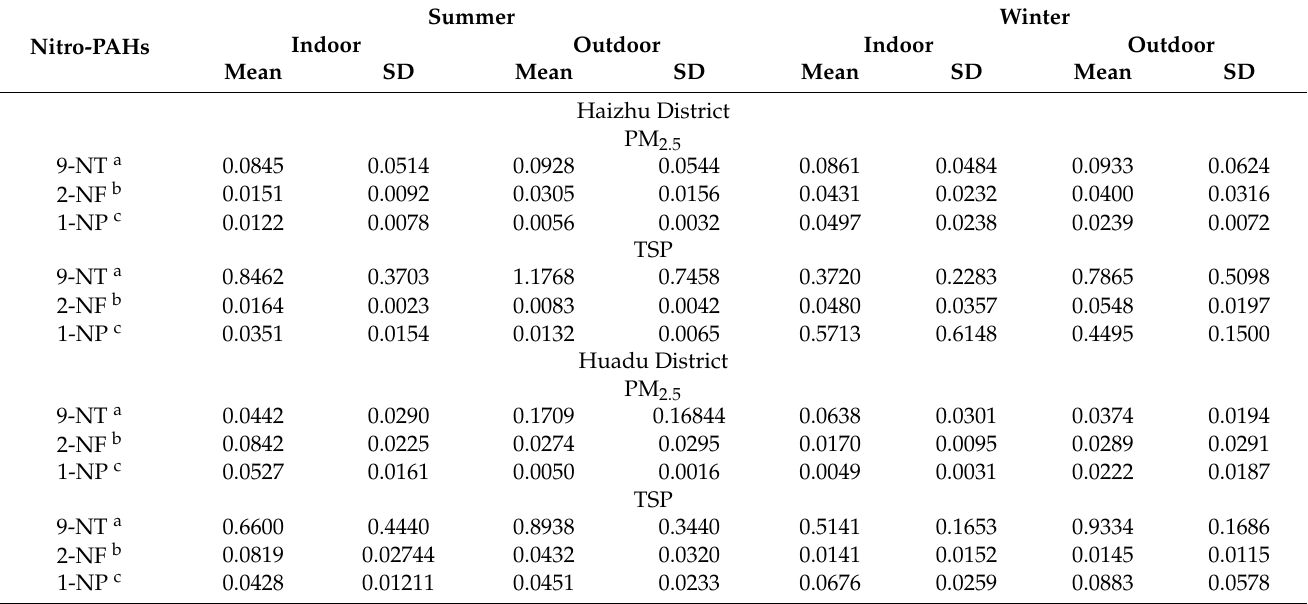
Table 2. Mean nitro-PAH concentrations (ng/m 3 ) and standard deviations of 9-NT, 2-NF, and 1-NP in PM 2.5 and TSP in